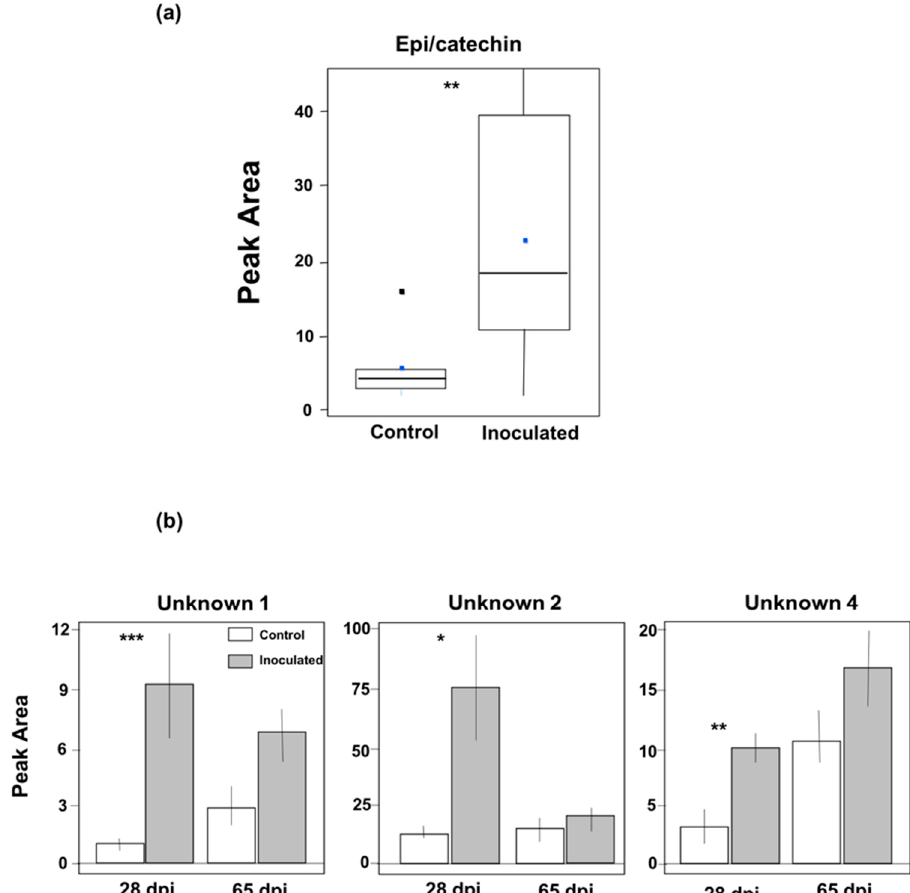
Figure 6. Effect of O. minus inoculation on individual phenolic metabolites in phloem tissue of P. strobus. ( a ) Median value Epi/catechin ( n = 7–11). Significant differences are indicated by an asterisk (*** p ≤ 0.001; ** p ≤ 0.01; * p ≤ 0.05); boxes show median and 1st and 3rd quartiles, and whiskers indicate 1.5 interquartile range. ( b ) Individual unknown compounds significantly induced due to fungal inoculation at 28 dpi. Error bar indicates Mean ± SE, ( n = 3–6). For terpene analyses samples from top and bottom were also combined. Monoterpene concentrations